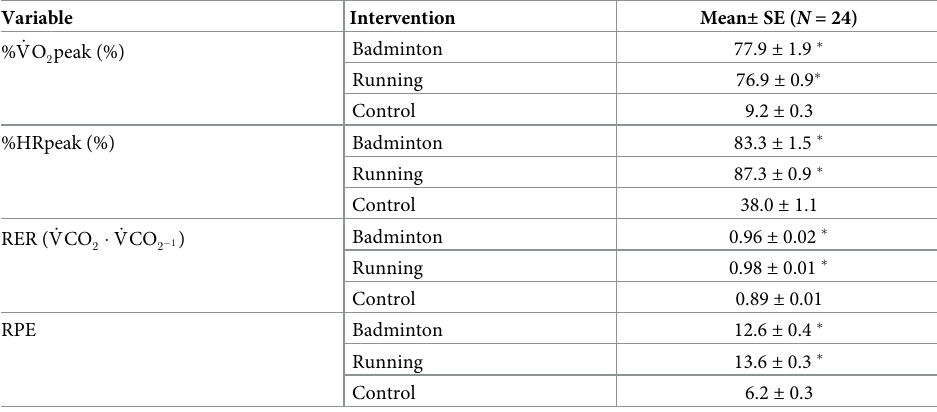
Table 2. Intensities of each intervention (mean ±